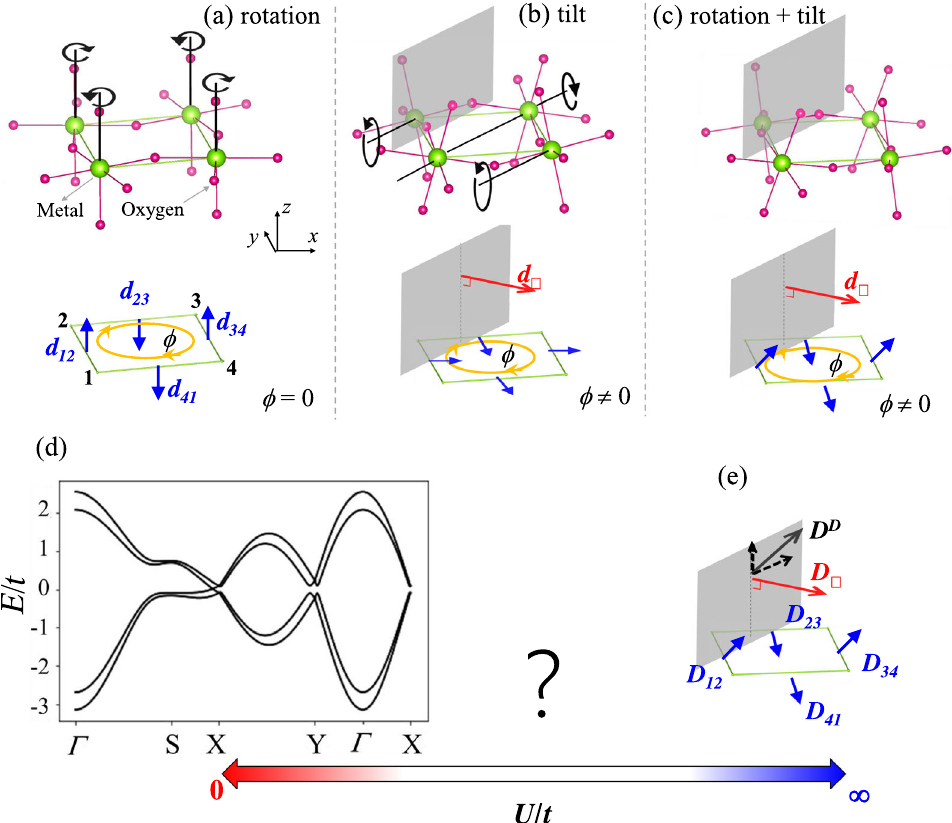
FIG. 4. Spin-dependent hopping of the Hubbard model. A perovskite square lattice with (a) octahedral rotations ( p 4 g wallpaper group containing a fourfold rotational symmetry and a glide reflection), (b) octahedral tilts ( pg wallpaper group containing a glide reflection), or (c) octahedral rotations and tilts ( pg wallpaper group). Bottom panels show the modulation of d vectors (blue arrows). Octahedral ij rotation or tilts on neighboring sites are opposite. The finite d □ (red arrow) in (b) and (c) is perpendicular to the mirror plane (gray) of the b -glide symmetry. (d) Representative U ¼ 0 band structure for a quasi-2D structure with two layers of square lattice (c) [53]. (e) Schematic diagram of Dzyaloshinskii – Moriya (DM) interactions on the square lattice (c) at the strong-coupling limit U ¼ ∞ . The blank space with a question mark highlights the extensive and largely unexplored intermediate region among the two